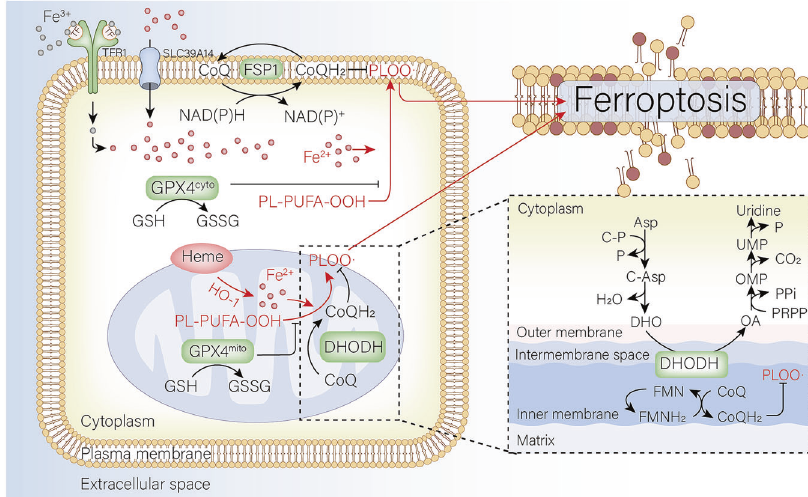
Fig. 1 Schematic model depicting the various pathways in the plasma membrane, cytoplasm, and mitochondria that lead to ferroptosis. Ferroptosis is characterized by iron-dependent cell death with accumulated PLOO. Iron uptake is controlled by TFR1-mediated diferric (Fe3 + ) transferrin-bound iron and SLC39A14-mediated non-transferrin-bound iron (Fe2 + ). Whereas PLOO-induced ferroptosis is regulated by either GSH-dependent GPX4 in the cytosol and mitochondria or GSH-independent FSP1 at the plasma membrane. Mao et al. identi fi ed DHODH coordinates with GPX4 to inhibit ferroptosis in the mitochondrial inner membrane. PLOO phospholipid hydroperoxyl radical, TFR1 transferrin receptor 1, GSH glutathione, GPX4 glutathione peroxidase 4, FSP1 ferroptosis suppressor protein 1, DHODH dihydroorotate dehydrogenase, CoA coenzyme A, PL-PUFA-OOH phospholipid-polyunsaturated fatty acid-hydroperoxide, GSSG oxidized glutathione, NAD(P)H reduced nicotinamide adenine dinucleotide (phosphate), NAD(P) + oxidized nicotinamide adenine dinucleotide